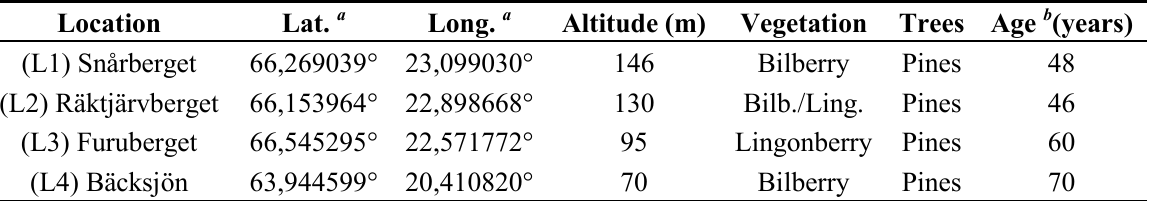
Table 4. Information regarding the sampling